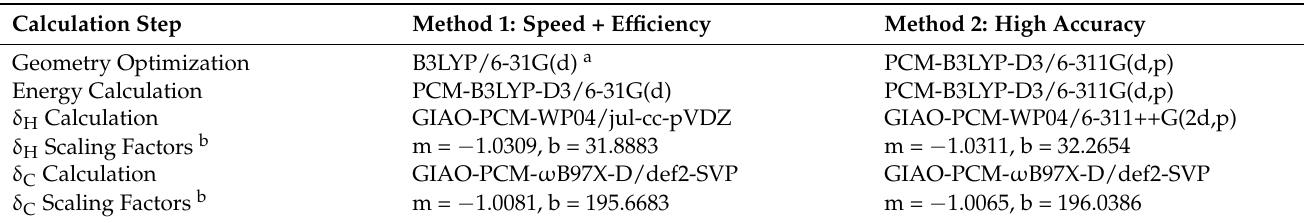
Table 7. Recommended DFT methods and linear scaling